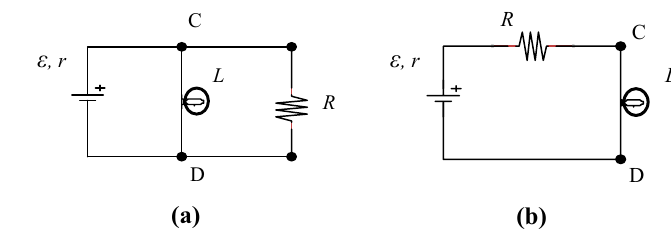
Fig. 8. Application of the Ohm’s and Kirchhoff’s